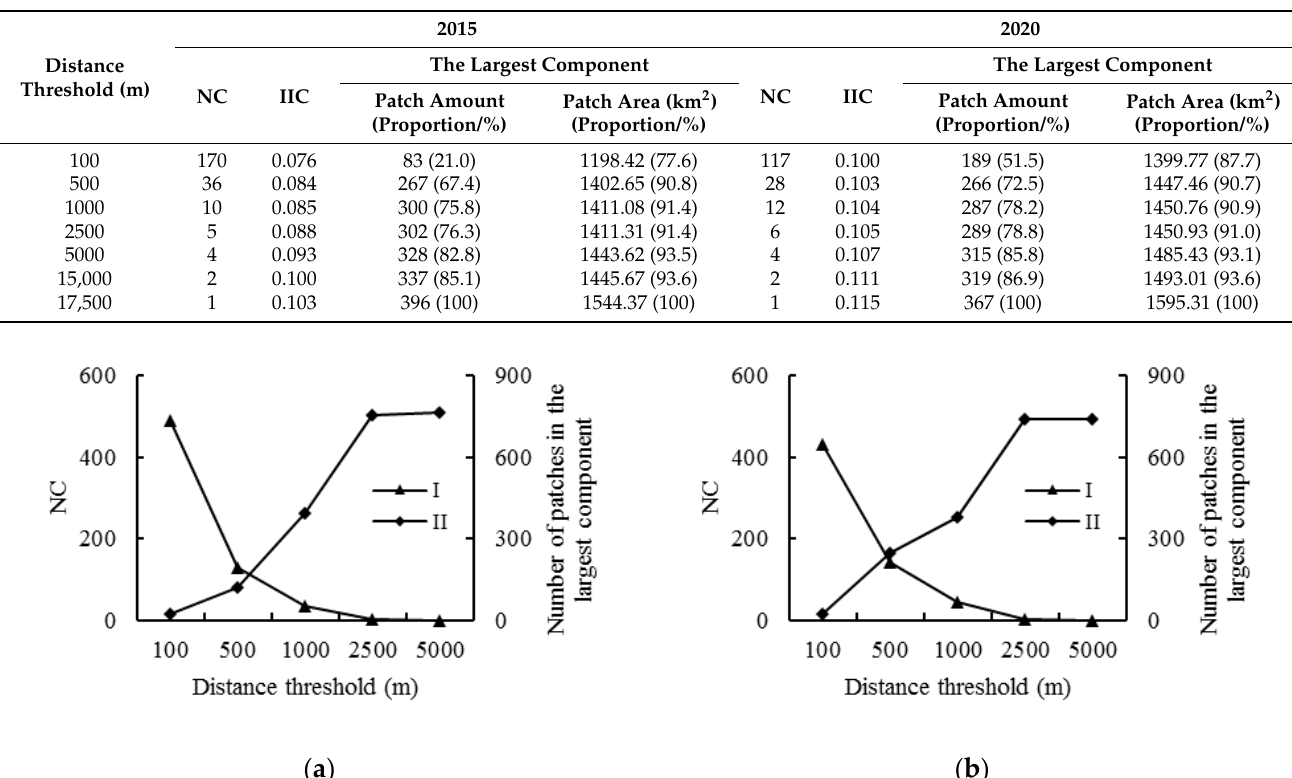
Table 3. FLC indices of low mountains under different distance thresholds.